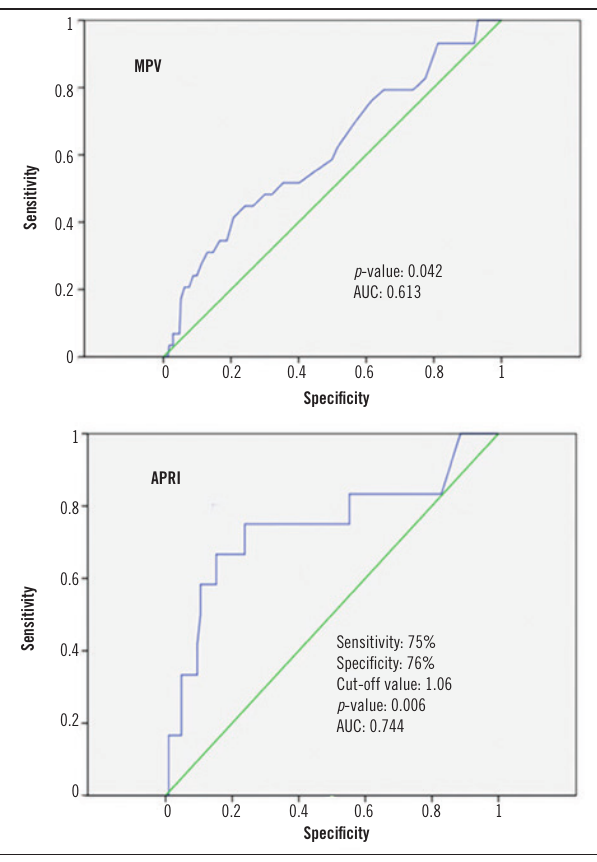
figurE − ROC curves of MPV and APRI in the prediction of significant discrimination of primary and secondary DENV infections. An AUC of 1 is characteristic of an ideal test, whereas an AUC of 0.5 or less indicates a test of no diagnostic